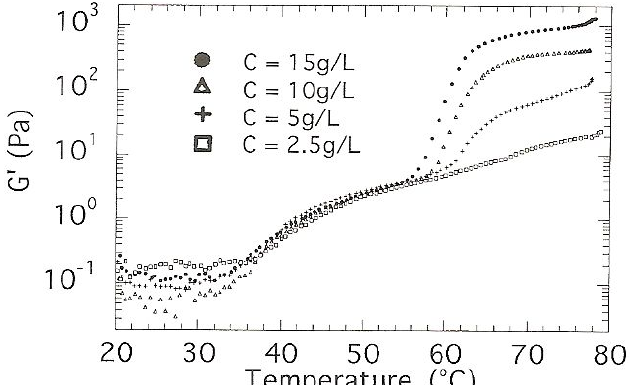
Figure 2. Influence of polymer concentration and temperature on the elastic modulus G’ (Pa at 1 Hz) of A4C solutions in water. Rate of temperature variation is 0.5 °/mn [2]. Reproduced from Polymer 1998 , 39, 6251-6259. Copyright 2010,